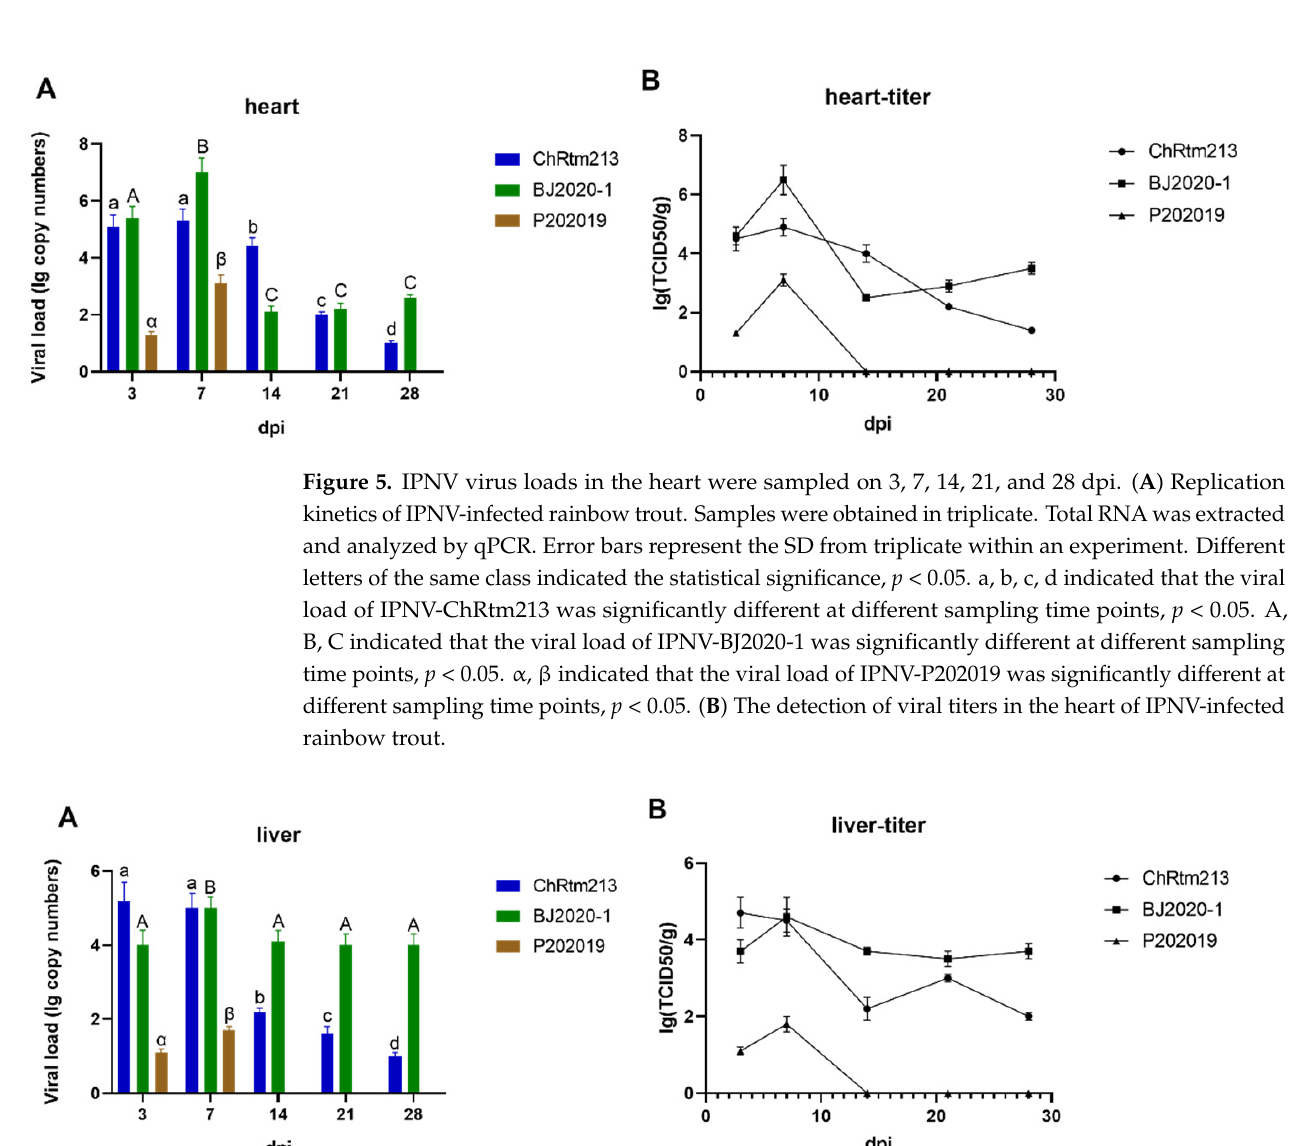
Figure 5. IPNV virus loads in the heart were sampled on 3, 7, 14, 21, and 28 dpi. ( A ) Replication kinetics of IPNV-infected rainbow trout. Samples were obtained in triplicate. Total RNA was ex- tracted and analyzed by qPCR. Error bars represent the SD from triplicate within an experiment. Different letters of the same class indicated the statistical significance, p < 0.05. a, b, c, d indicated that the viral load of IPNV- ChRtm213 was significantly different at different sampling time points, p < 0.05. A, B, C indicated that the viral load of IPNV- BJ2020-1 was significantly different at different sampling time points, p < 0.05. α , β indicated that the viral load of IPNV- P202019 was significantly different at different sampling time points, p < 0.05. ( B ) The detection of viral titers in the heart of IPNV-infected rainbow trout.